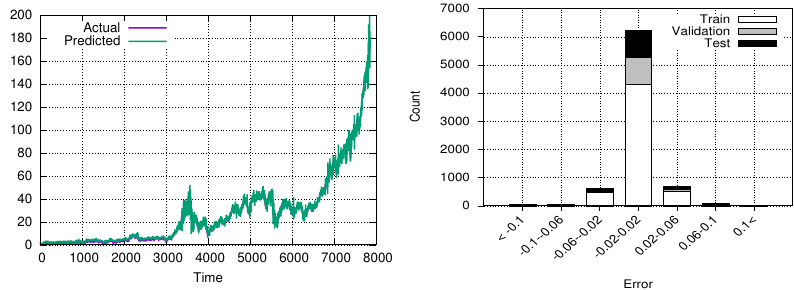
Figure 3. Actual vs. Predicted: NARX. Figure 4. Actual vs. Predicted: ARIMA. Figure 5. Error Histogram of Adobe